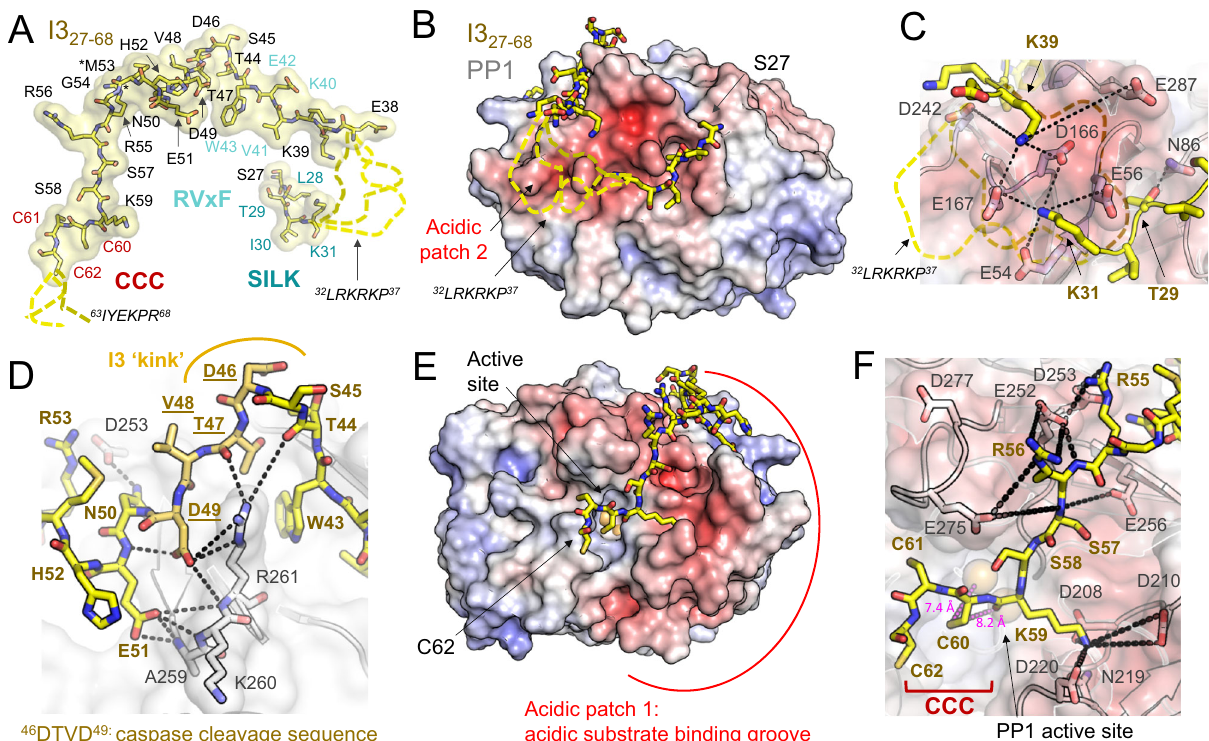
Fig.2|TheI3:PP1holoenzyme.A ThestructureofI3whenboundtoPP1;residues shown as sticks and labeled. PP1 motif residue labels are colored as in (1A). I3 residuesnotmodeledduetoalackofelectrondensityindicatedbydashedlinesin yellowhues. B TheI3:PP1complexwithI3shownasyellowsticksand PP1shownas a surface coloredaccording to electrostaticpotential. The location ofacidicpatch 2 is indicated. I3 residues not modeled due to a lack of electron density indicated bydashedlinesinyellowhues. C CloseupofPP1acidicpatch2.PP1acidicresidues shown as sticks and labeled (gray) with I3 residues shown as sticks (yellow). Elec- trostatic/polarinteractionsindicatedbyblackdottedlines.DynamicI3residues 31 – 37 indicatedbydashedlinesinyellowhues. D TheI3 ‘ kink ’ .PP1shownasatransparent